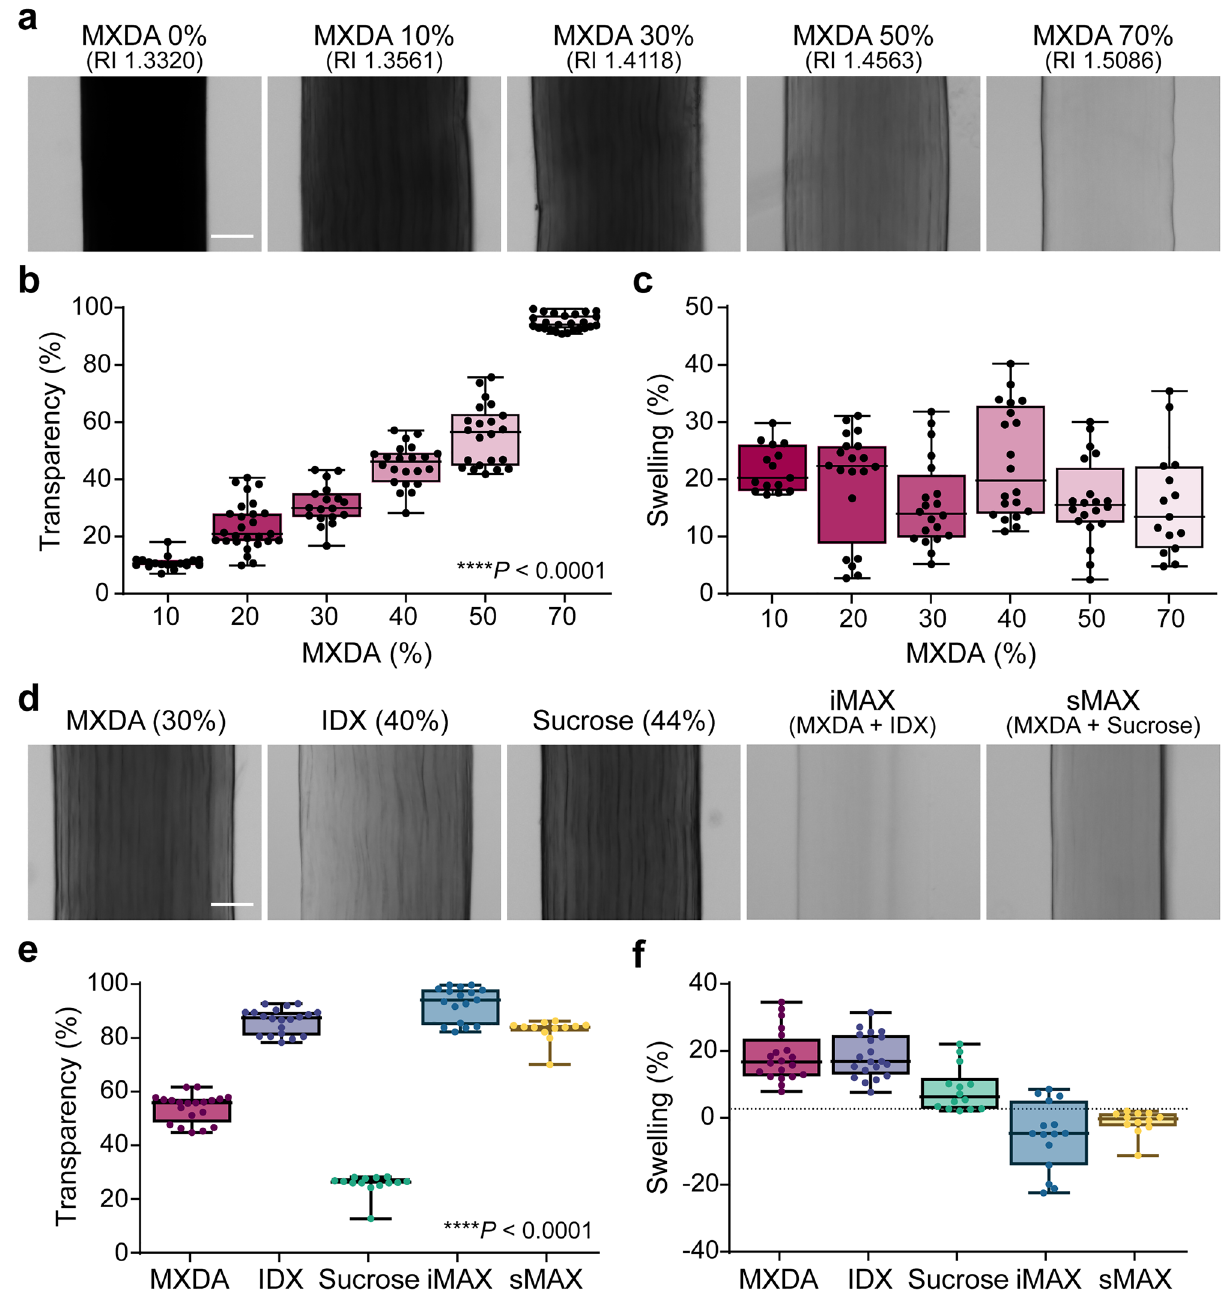
Figure 1. Optimization of the MXDA-based extracellular matrix (ECM) clearing media. ( a ) Changes in the size and transparency of the rat tail tendon (RTT) depending on the concentration of the MXDA. Right graphs show the densitometric quantification results. Scale bar, 100 μm. ( b ) Quantification of RTT transparency and ( c ) swelling percent in different MXDA concentrations N = 9 animals. Data spots were obtained from 1–3 different RTTs from individual animals. ( d ) Effects of MXDA (40%) with iodixanol (IDX) or sucrose on the transparency and size of RTT. Both mixtures (iMAX or sMAX) were adjusted to RI = 1.47. Scale bar, 100 μm. ( e , f ) Quantification of transparency ( e ) and swelling percent ( f ) in the mixtures, N = 6 animals. Data spots were obtained from 1–3 different RTTs from individual animals. Standard one-way ANOVA with Tukey’s multiple comparison test was used for multiple comparisons ( b , e